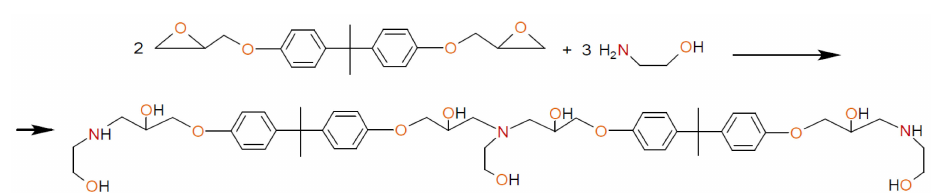
Figure 1. Formation of AEBA.